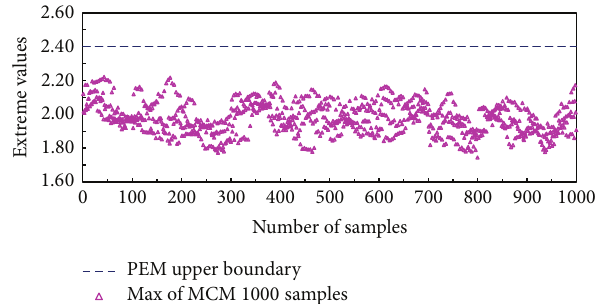
Figure 20: Comparison of vertical acceleration of bridge girder